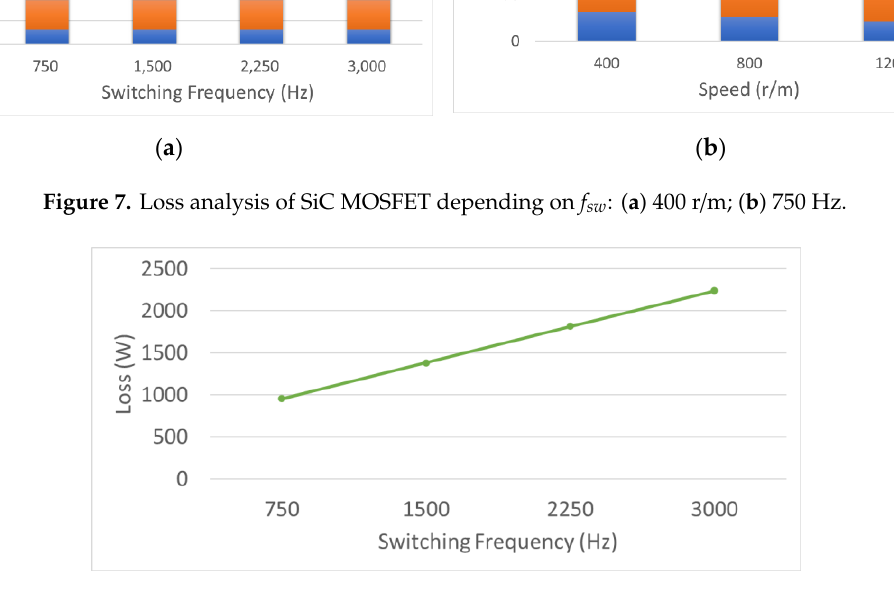
Figure 8. Total loss of SiC inverter depending on f sw .